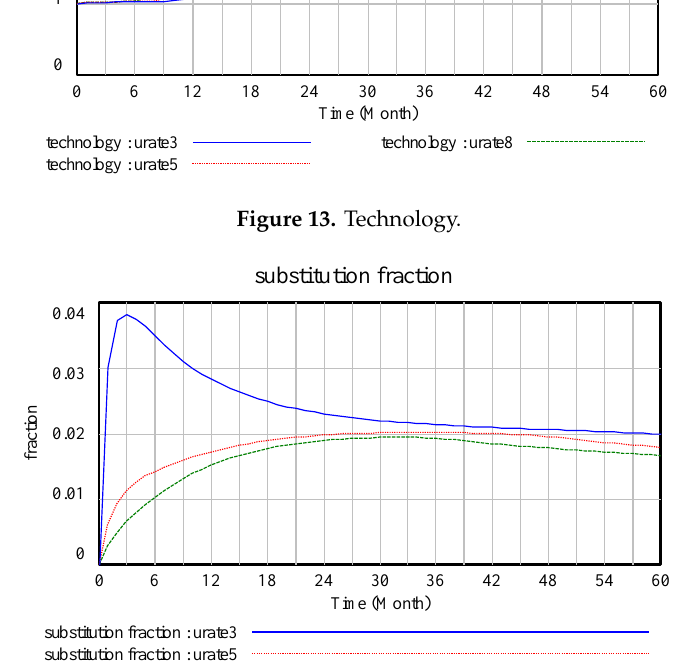
Figure 14. Substitution fraction.